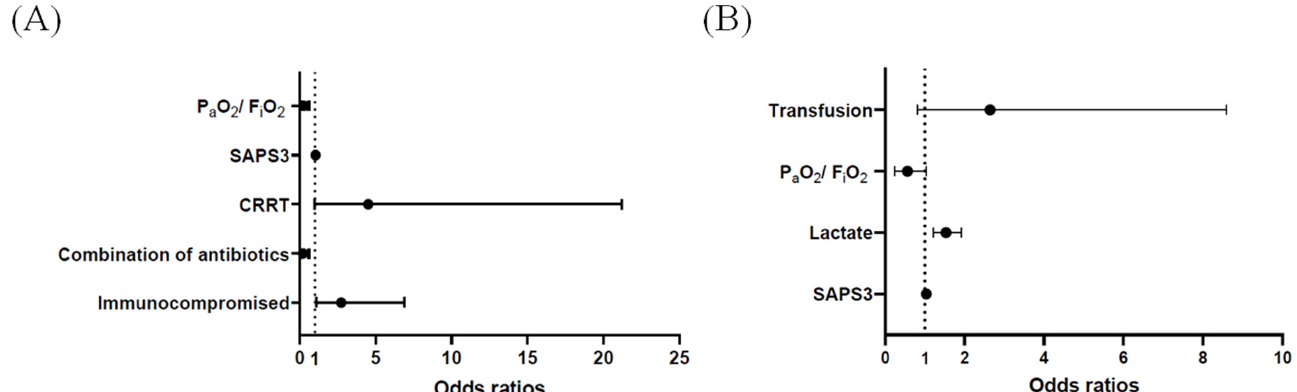
Figure 3. Odds ratios and 95% confidence intervals for early high-flow nasal cannula failure by multivariable analysis in ( A ) pneumonia sepsis and ( B ) non-pneumonia sepsis patients. CRRT: continuous renal replacement therapy; SAPS3: simplified acute physiology score3. Table 3. Risk factors for HFNC failure in patients with pneumonia sepsis ( n = 117) a . Univariable Analysis Variables